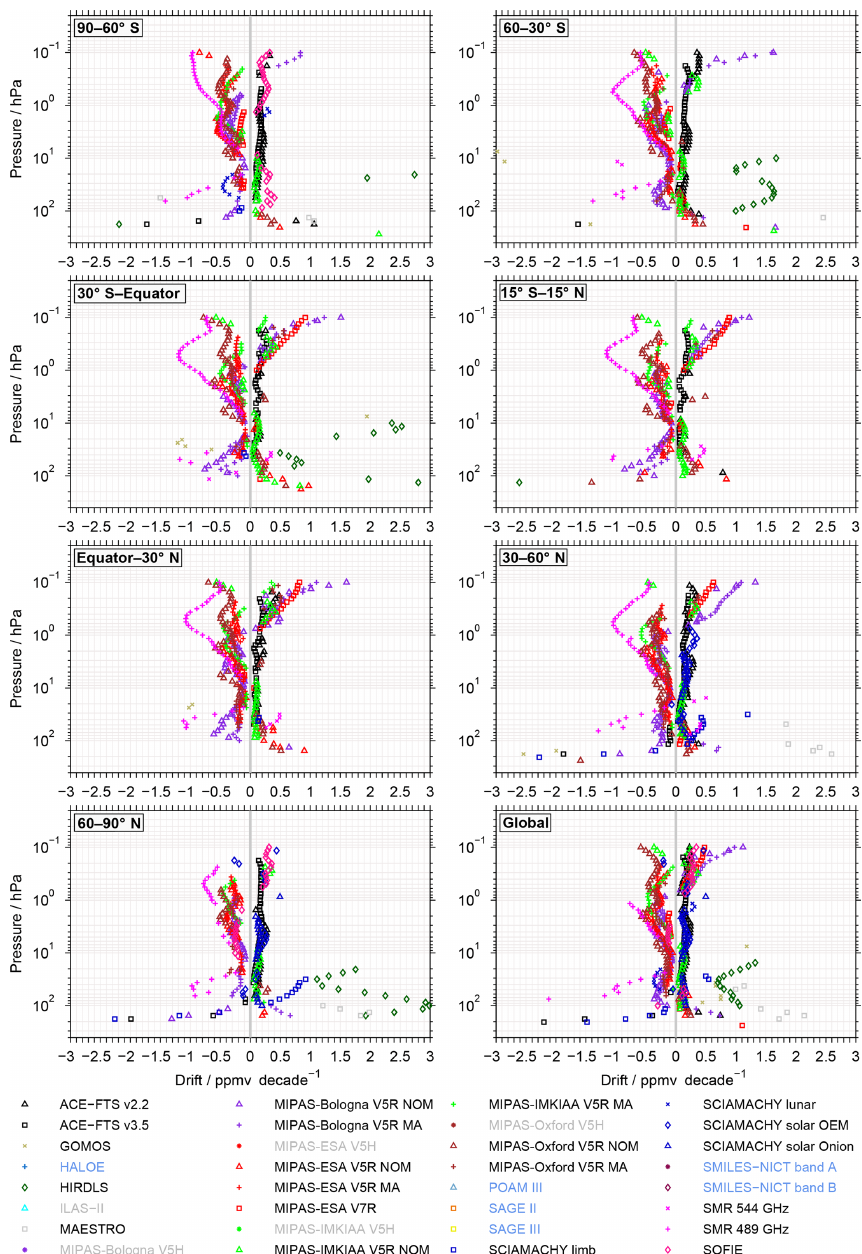
Figure 14. As in Fig. 13 but considering the MLS data set here.